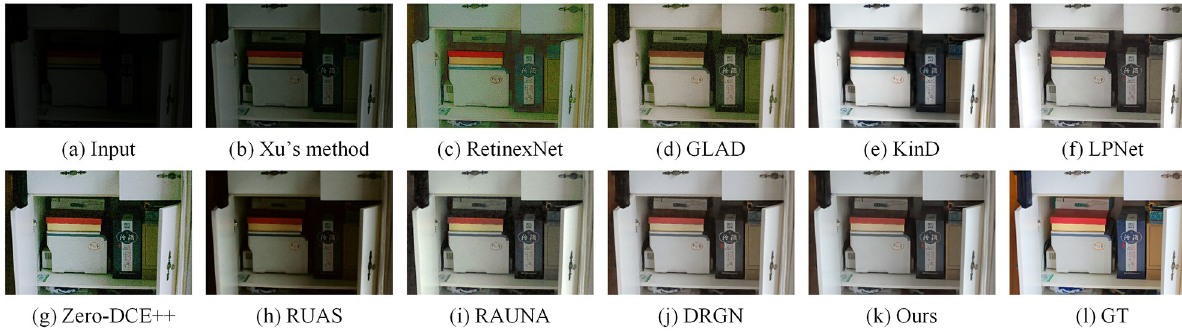
Fig 5. Visual results of different methods on LOL dataset for image number 55. (a) Input. (b) Xu’s method. (c) RetinexNet. (d) GLAD. (e) KinD. (f) LPNet. (g) Zero-DCE++. (h) RUAS. (i) RAUNA. (j) DRGN. (k) Ours. (l) GT.